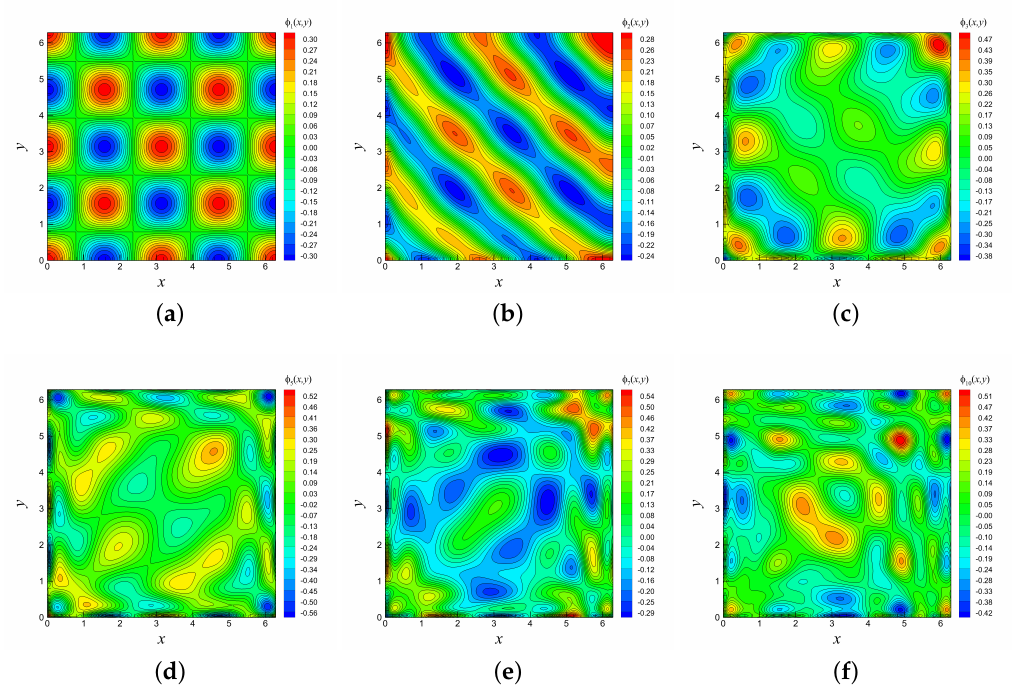
Figure 8. Contour plots of some illustrative POD basis functions generated by the method of